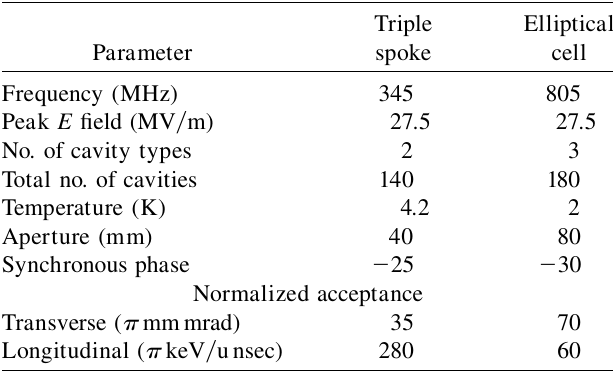
TABLE V. Summary of the parameters for the two design options for the high-energy section of the RIA driver